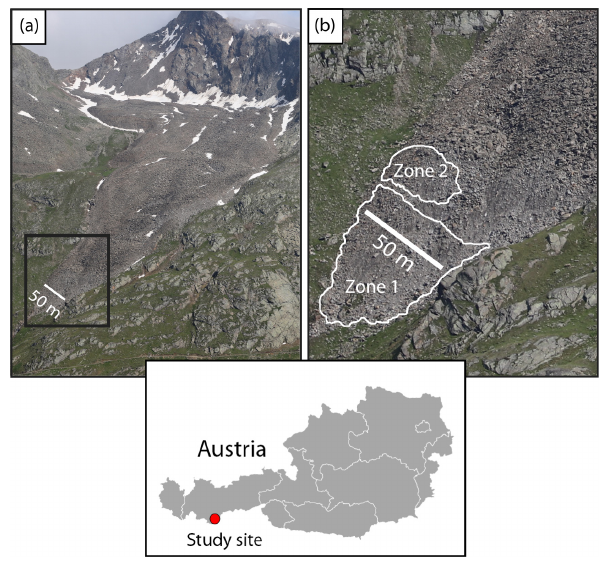
Figure 1. The Äußeres Hochebenkar rock glacier. (a) View of Hochebenkamm across the rock glacier (looking south) from the opposite side of the Gurgler Valley. (b) A close-up of the inset in panel (a) showing the lower tongue area. Active zone 1 comprises the rock glacier front, and active zone 2 represents a ridge above the rock glacier front, which exhibits negative surface change in the direction normal to the surface in both periods. Map data were sourced from the GADM database (https://www.gadm.org/, last ac-